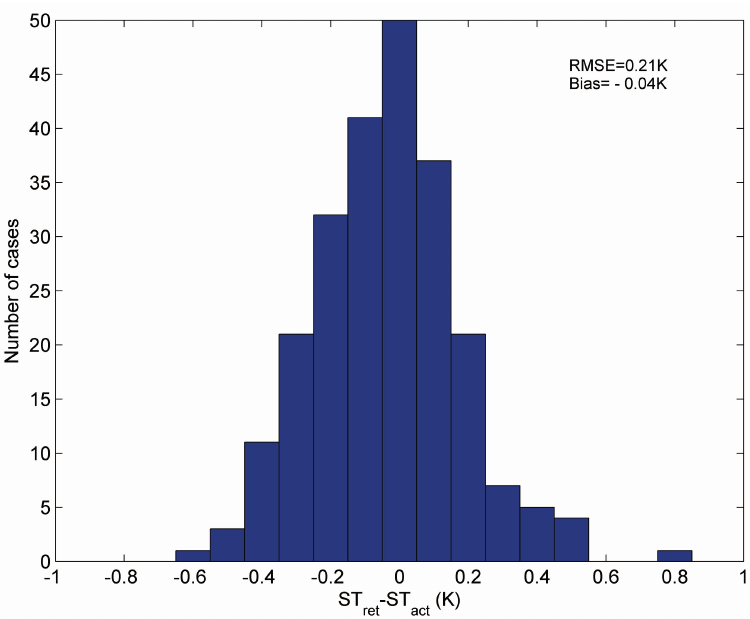
Figure 6. Error of the ST retrieved by Equation (3) from independent simulation data with the 39 atmospheric profiles. (ST ret = the retrieved ST, ST act = the true